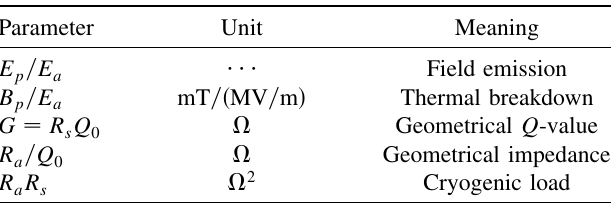
TABLE III. Most important rf parameters of superconducting cavities.